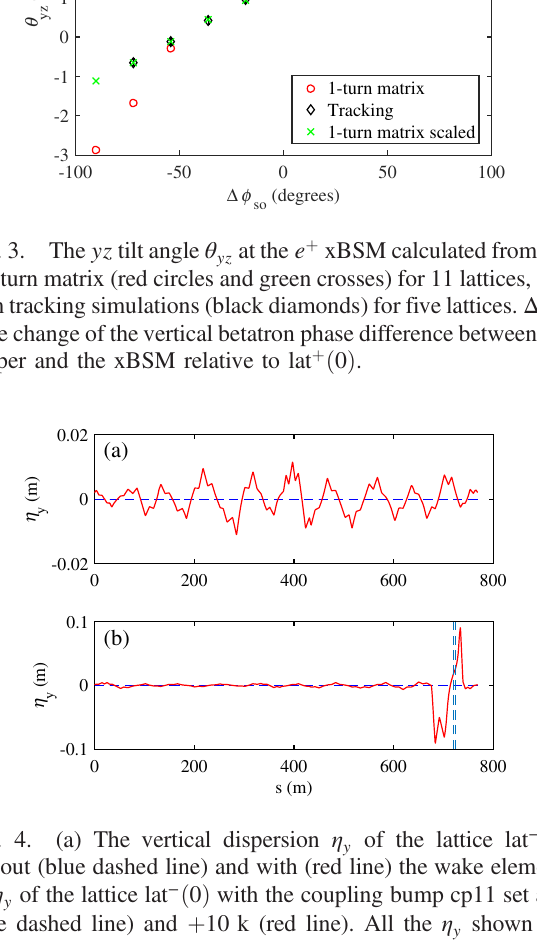
FIG. 4. (a) The vertical dispersion η y of the lattice lat − ð 0 Þ without (blue dashed line) and with (red line) the wake element. (b) η y of the lattice lat − ð 0 Þ with the coupling bump cp11 set at 0 (blue dashed line) and þ 10 k (red line). All the η y shown are calculated from lattice models. The vertical dashed line indicates the location of the east rf